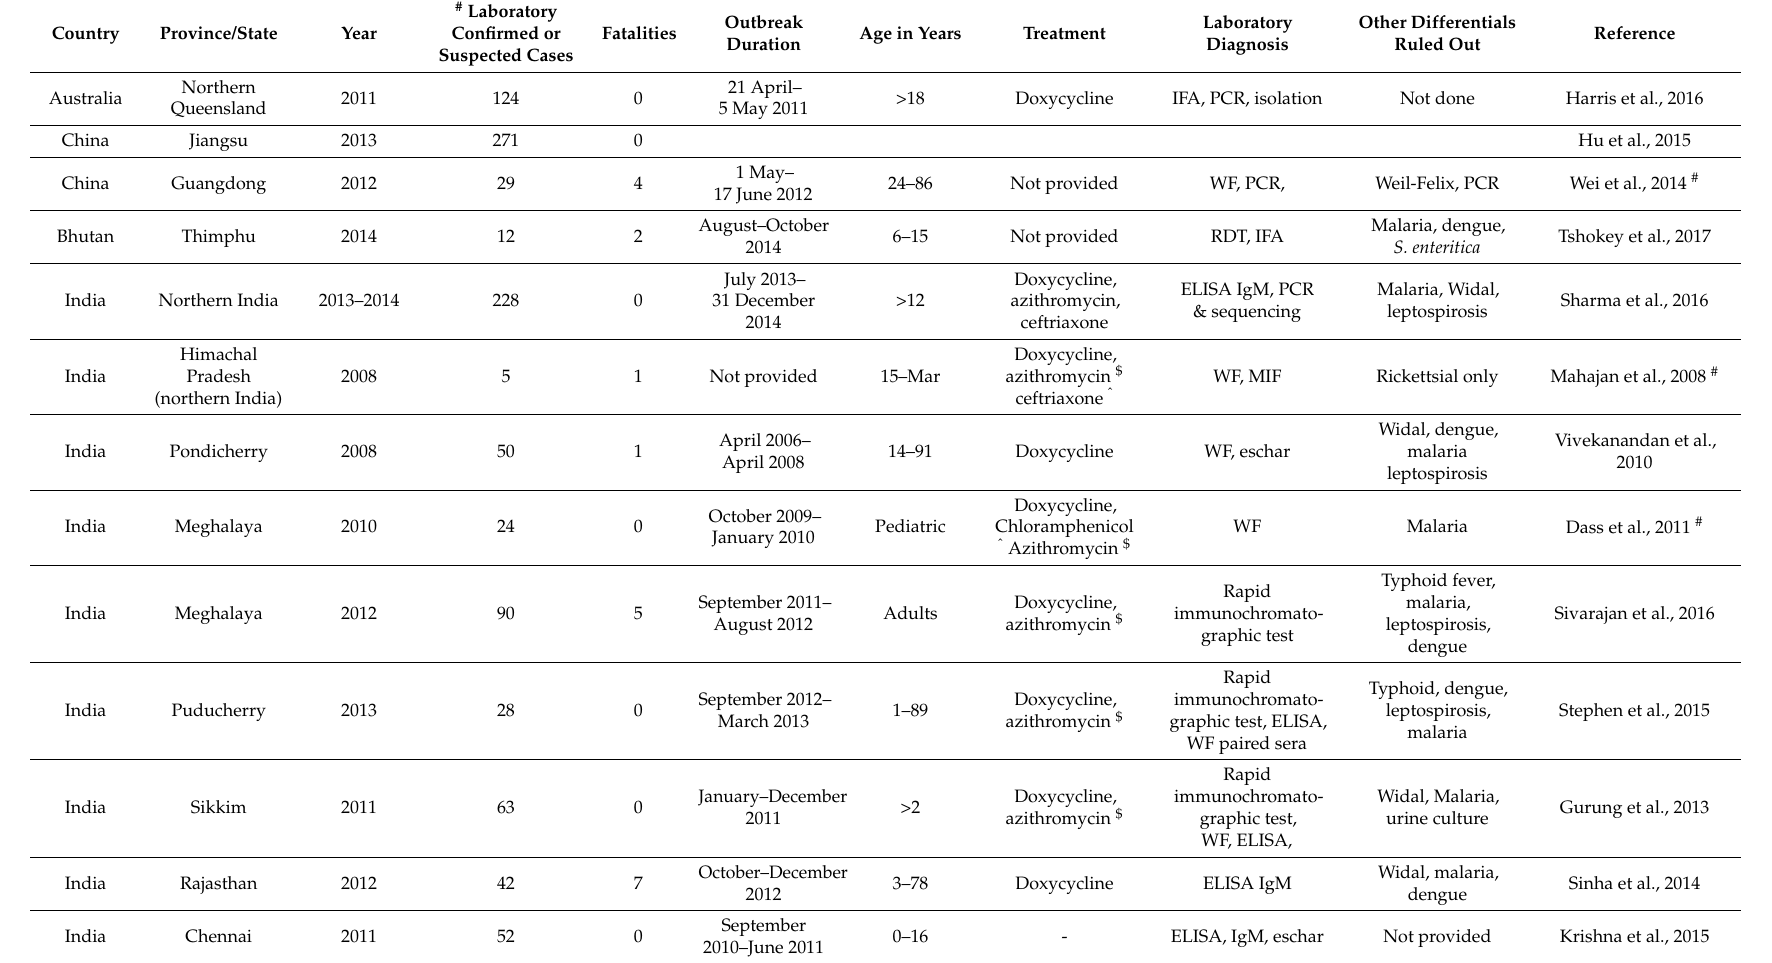
Table 1. Human outbreaks of scrub typhus from 2007 to present,